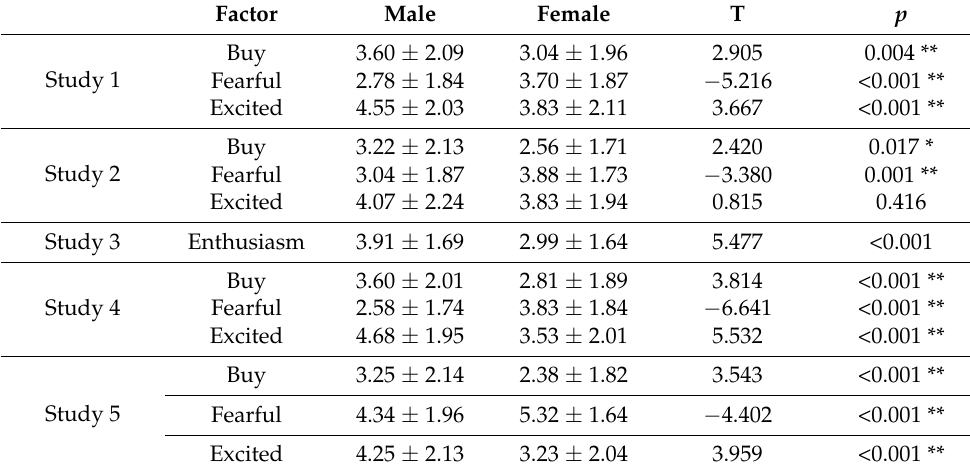
Table 7. Independent sample t -test for gender.